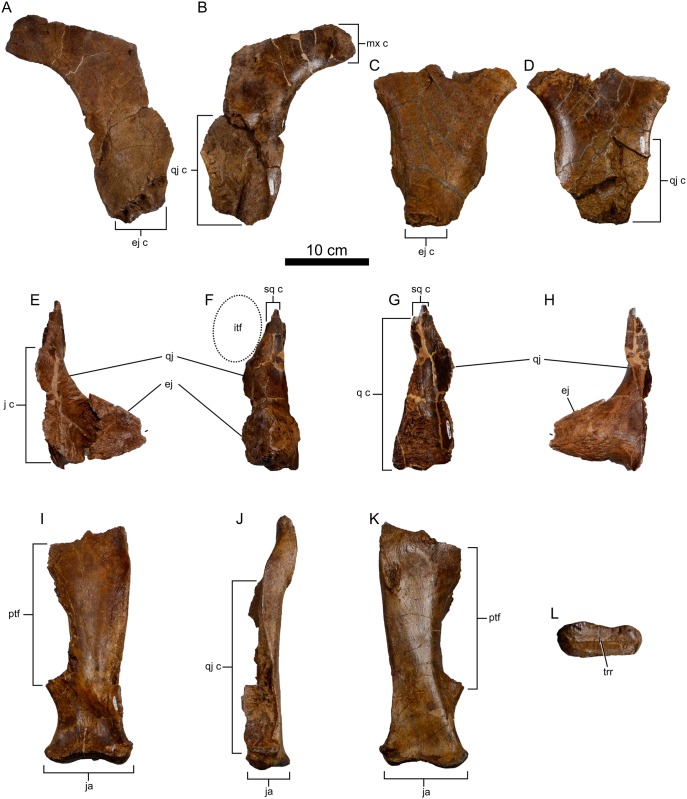
Infratemporal elements of Spiclypeus shipporum gen et sp. nov. (CMN 57081).Left jugal in lateral (A) and medial (B) views; right jugal in lateral (C) and medial (D) views; left quadratojugal and epijugal in anterior (E), lateral (F), medial (G), and posterior (H) views; left quadrate in anterior (I), lateral (J), posterior (K), and ventral (L) views.